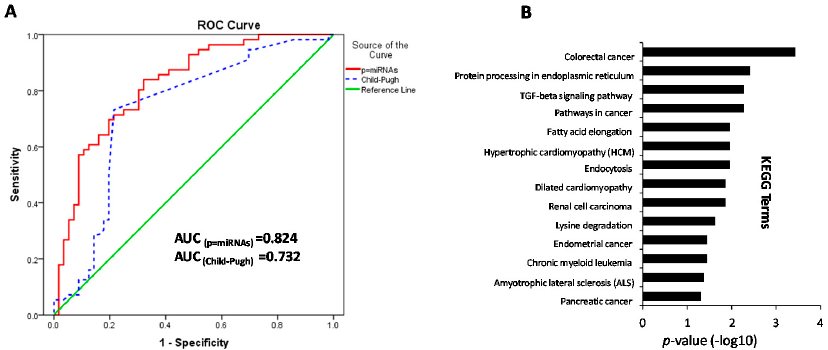
Figure 5. The KEGG terms of miRNA panel and the comparison of ROC between the miRNA panel and Child–Pugh. ( A ) ROC curves from the miRNA panel data and Child–Pugh data. ROC curve ( p = miRNAs) generated using the miRNA expression data in the miRNA panel; the AUC was 0.824 ( p = 0.000). The ROC curve of Child–Pugh was generated using the Child–Pugh score; the AUC was 0.732 ( p = 0.000); ( B ) The miRNA combination of hsa-miR-18a-5p, -326, -1182 and -193b-5p associated with the KEGG